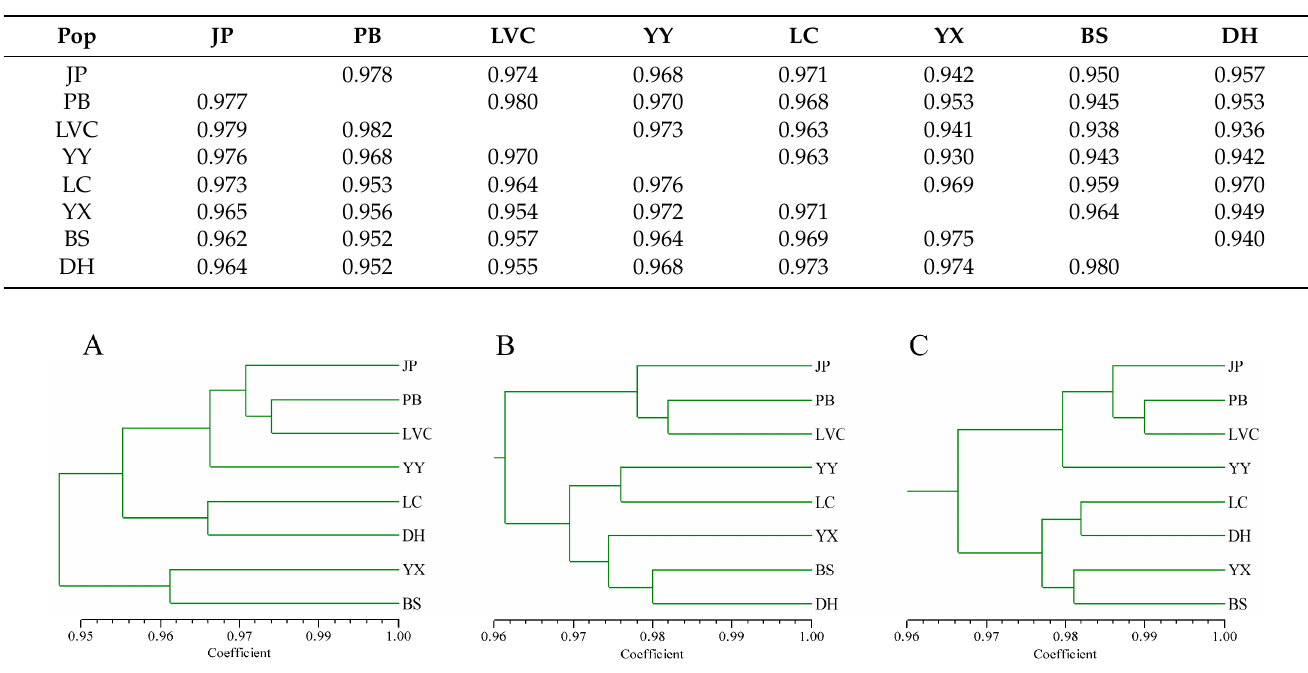
Figure 6. UPGMA cluster ( A ) and principal coordinates analysis (PCoA) ( B ) of the 96 A. tsao-ko ac- cessions based on PAAP and CDDP markers. 3.6. Population Atructure of A. tsao-ko Accessions To further understand the genetic relationships between the A. tsao-ko accessions, we performed model-based population structure analysis using STRUCTURE software.